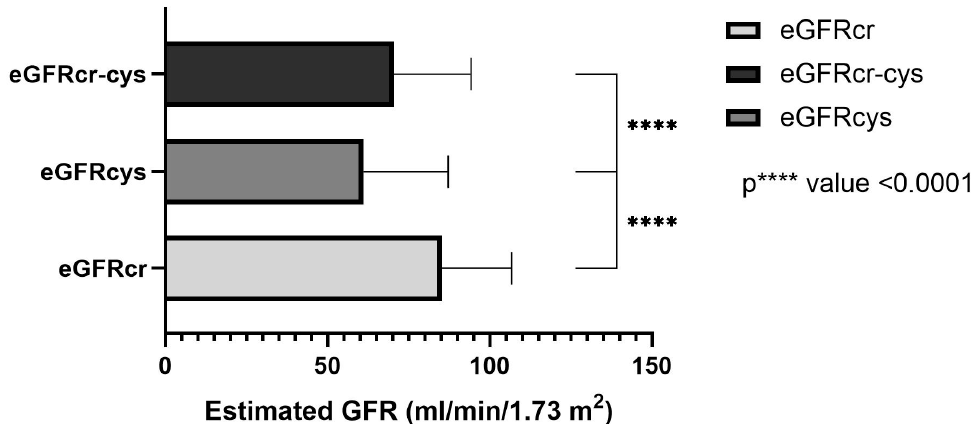
Figure 1. Estimated GFR (mL/min/1.73 m 2 ) of the three equations which is based on creatinine (eGFRcr), cystatin C (eGFRcys) and combined creatinine-cystatin C-based (eGFRcr-cys). The one-way ANOVA test shows a significant difference between all three equations ( p **** value <0.0001, r = 0.147).